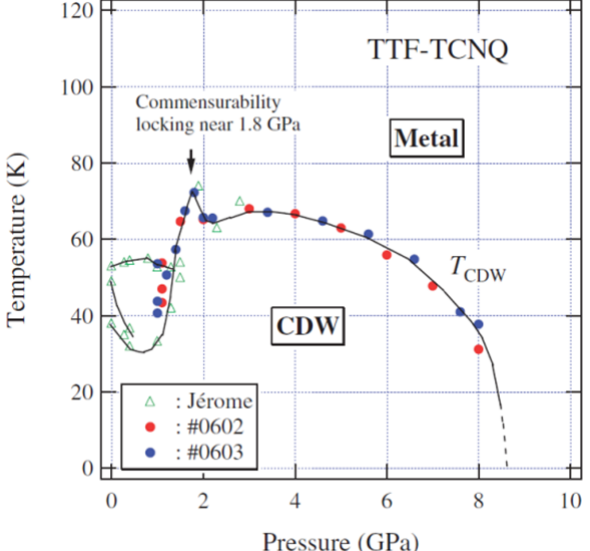
Figure 1. Temperature-Pressure phase diagram of TTF-TCNQ. Preceding work up to 3 GPa [29], including the (charge density wave) CDW commensurability peak at 1.9 GPa [31] is reproduced. The CDW is suppressed by pressure even though nesting becomes better. Reproduced with permission from